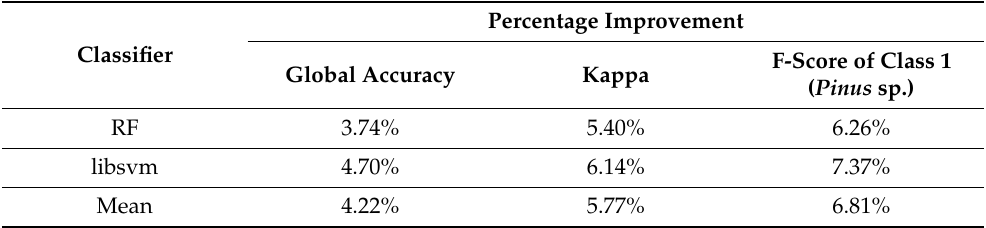
Table 8. Mean improvement obtained in the kappa and F-score indices of Class 1 ( Pinus sp.) with the use of the techniques employed to improve